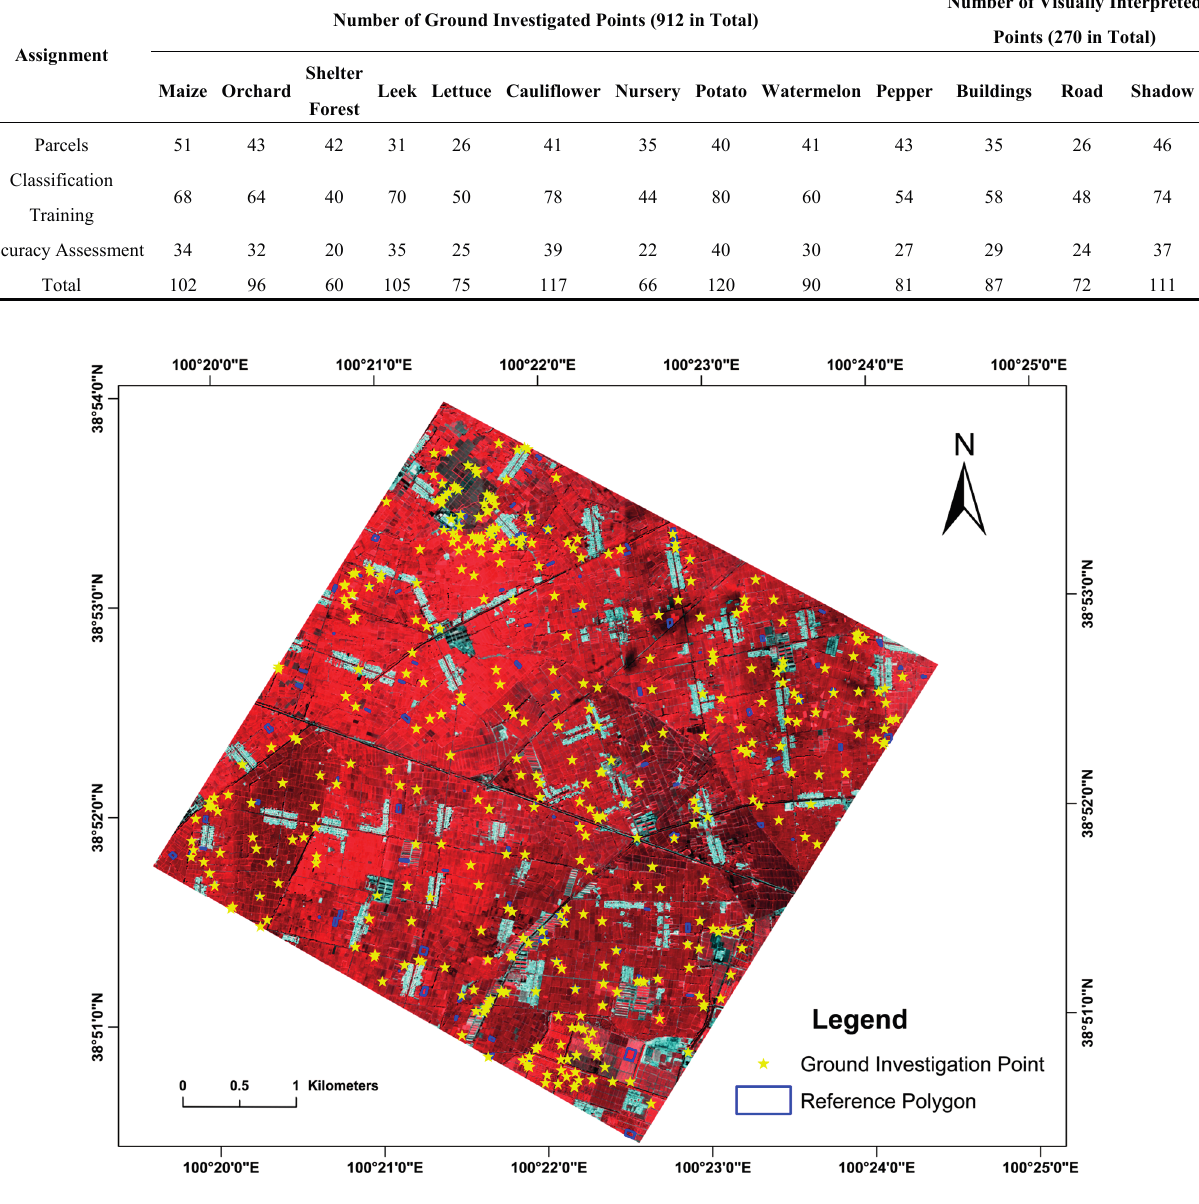
Table 1. Details of the ground truth data used for classifier training and classification accuracy assessment.